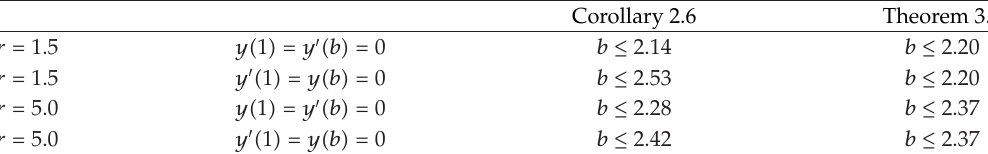
Table 2: Comparison of upper bounds for b in Example 4.2. Corollary 2.6 Theorem